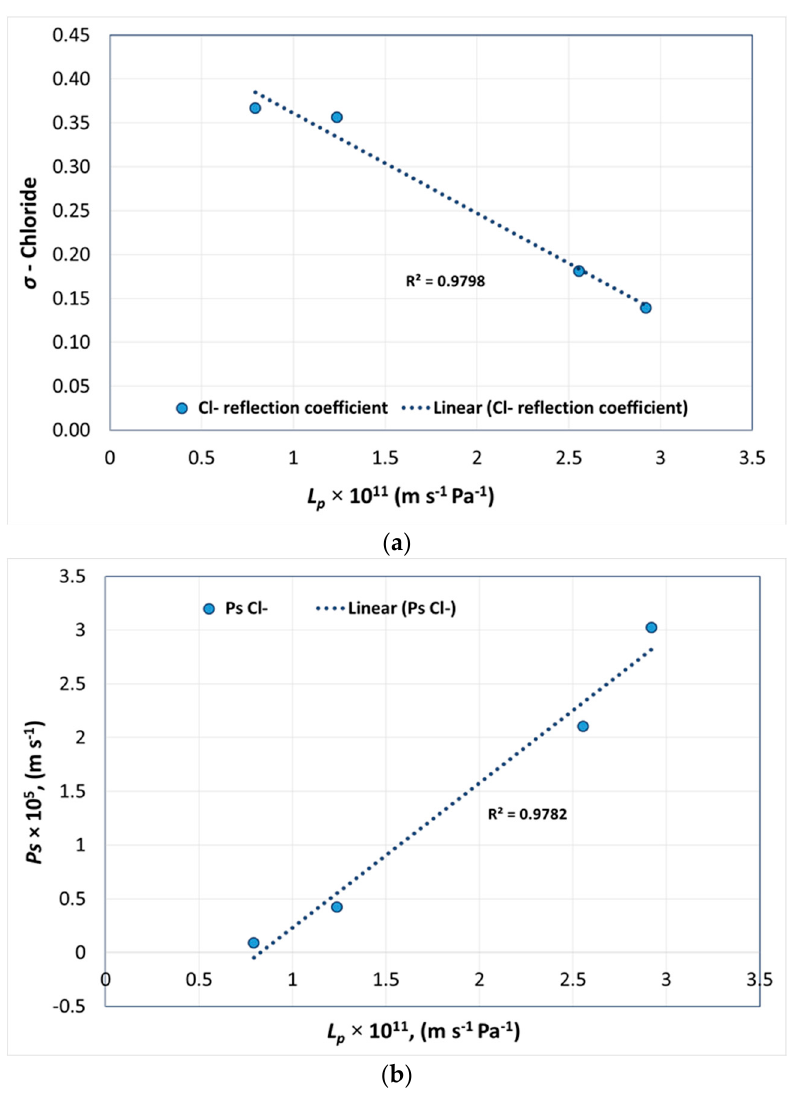
Figure 3. Pure water permeability versus ( a ) reflection coefficient and ( b ) solute permeability of chloride.